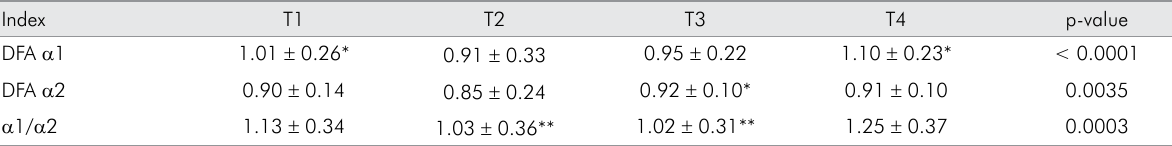
Table 2. Mean and standard deviation of fractal analysis indexes in T1, T2, T3 and T4.